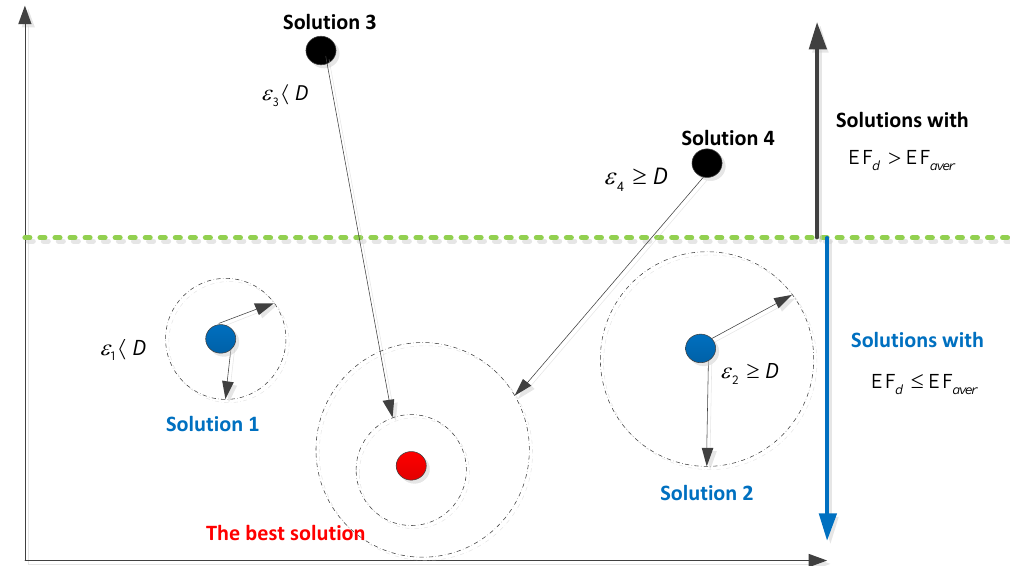
Figure 4. The description of the first update process of the proposed modified stochastic fractal search algorithm (MSFS) method. Algorithm 2. The proposed search strategy for the first update process Calculate given probability of solution d by utilizing Equation